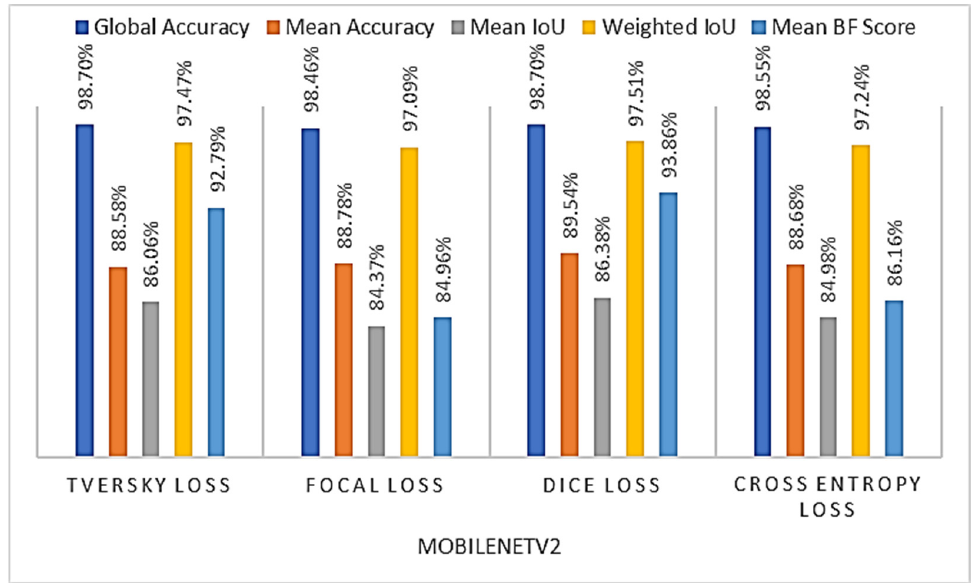
Figure 4. The overall metrics were gathered using different loss functions with Deeplabv3+ with MobileNetV2 as the backbone.